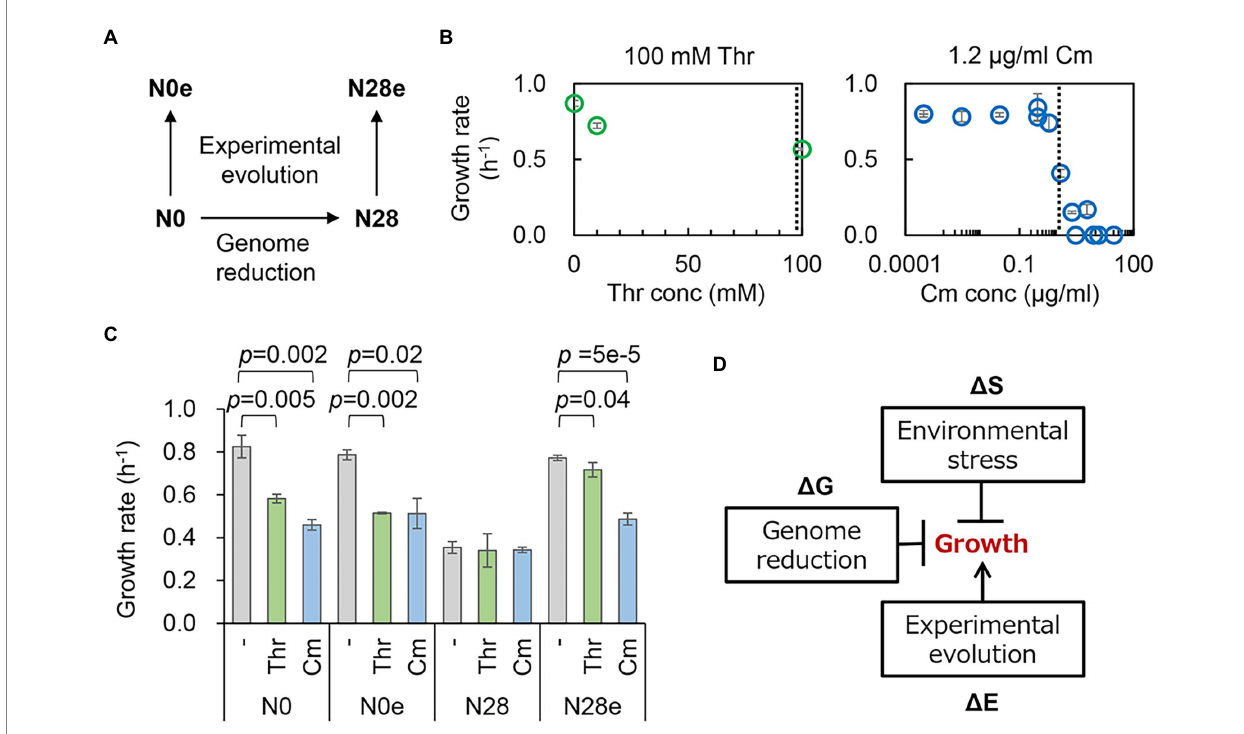
FIGURE 1 Changes in growth fitness in response to genomic, environmental, and evolutionary changes. (A) An overview of the E. coli strains. The wild-type and reduced genomes are indicated as N0 and N28, respectively. The evolved N0 and N28 are indicated as N0e and N28e, respectively. (B) Contribution of the concentration gradient of the additives to growth fitness. The selected concentrations of the additives are indicated by the broken lines. (C) E. coli growth rates. N0, N28, N0e, and N28e indicate the wild-type, reduced, evolved, and evolved reduced genomes, respectively. Thr and Cm stand for threonine and chloramphenicol, respectively. The statistical significance ( p values) of Welch’s t -tests are indicated. (D) Schematic drawing of the contributions of genomic, environmental, and evolutionary changes to bacterial growth. The changes mediated by genome reduction, environmental stressors, and experimental evolution are represented as Δ G, Δ S, and Δ E, respectively. The arrow and T cross from the boxes stand for the improvement and inhibition of growth, respectively.